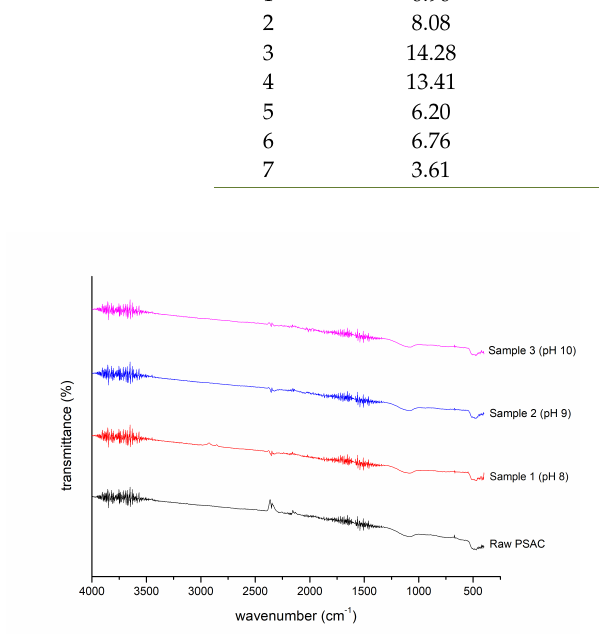
Fig. 6. FTIR spectrum of raw PSAC and Ni-PSAC at dif- ferent pH.